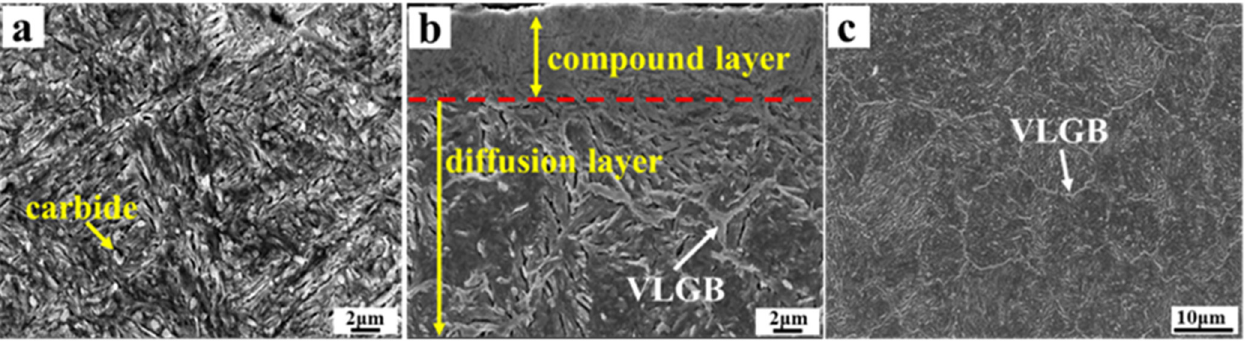
Figure 3. ( a ) Carbide distribution in the C state, ( b ) compound layer and part of the di ff usion layer in the N state, ( c ) di ff usion layer in the N state.